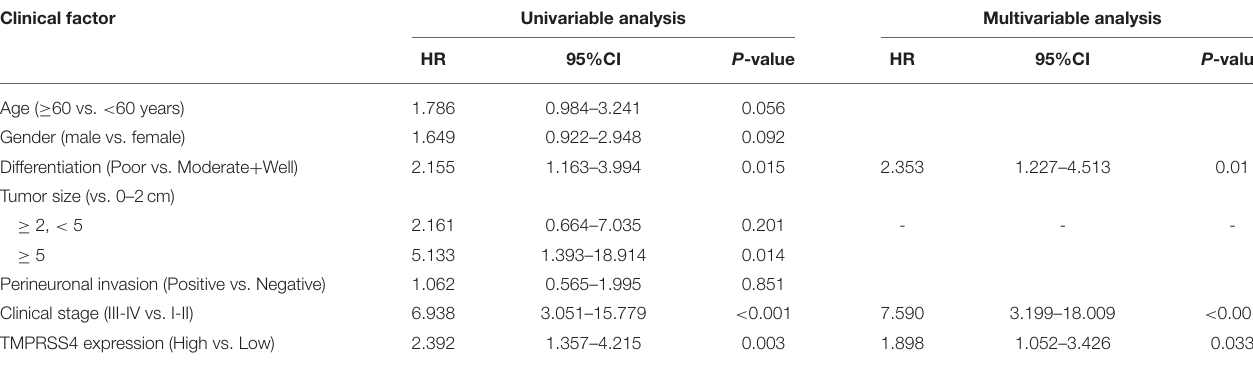
TABLE 2 | Cox univariable and multivariable analysis of clinicopathological variables and TMPRSS4 expression in relation to OS in pancreatic cancer patients. Clinical factor